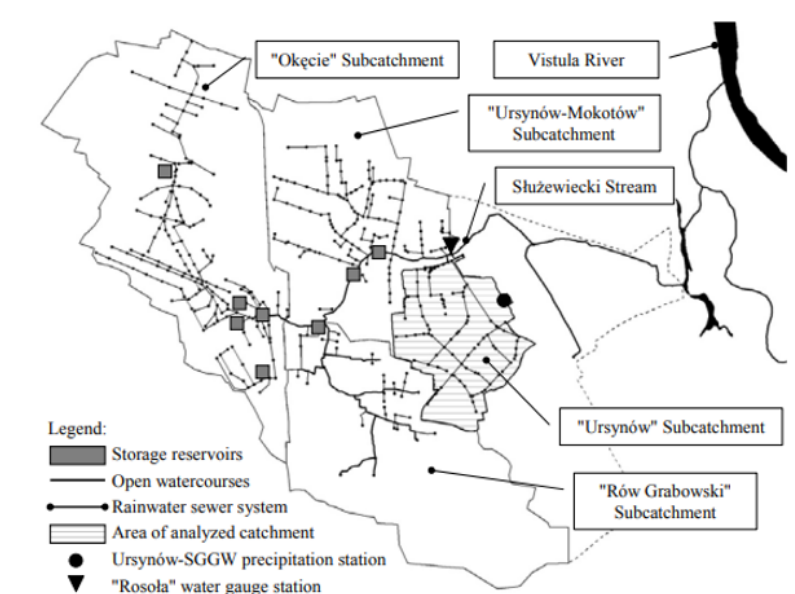
Figure 2. Catchment area of the Słu˙zewiecki Stream up to the “Rosoła” measurement profile (Source: M.P. Barszcz).